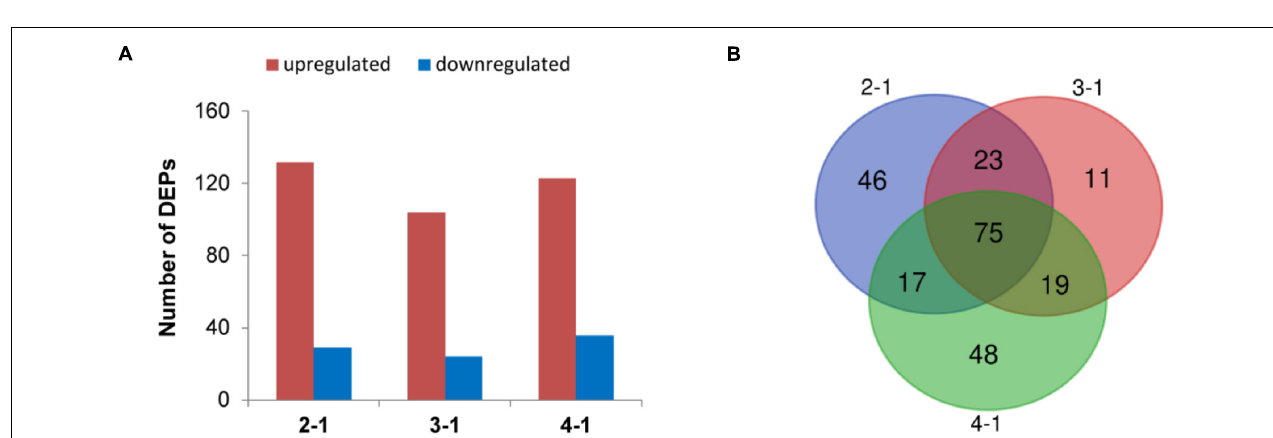
FIGURE 1 | (A) Changes in L* values (mean ± SE, n = 5) of surface mycelia of Lentinula edodes grown under illumination (75 days under a 12-h dark/12-h light regime). L* values represent the lightness of color in the Commission International Eclairage L*a*b* (CIELAB), with maximum L* = 100 representing a perfect reflecting diffuser and minimum L* = 0 representing black. (B) Characterization of brown film formation of mycelium at development four times.